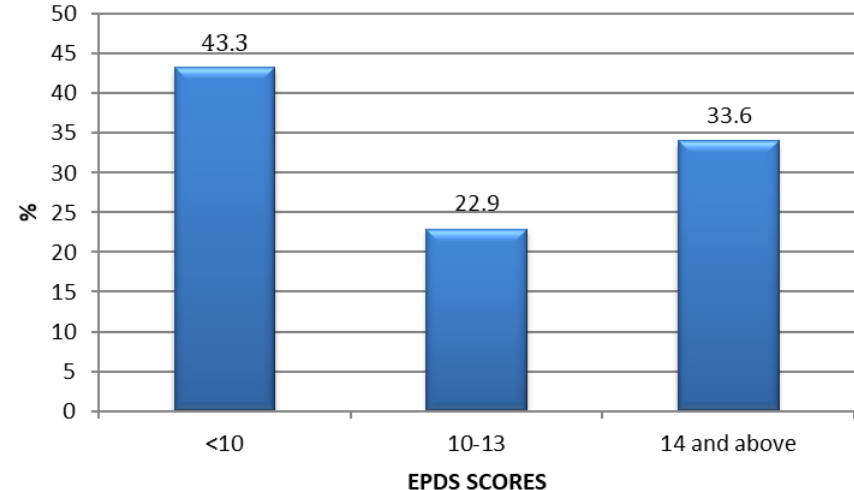
Figure 1. Prepartum depression among pregnant women in urban low income Nairobi -Kenya EPDS (Cutoff >13).